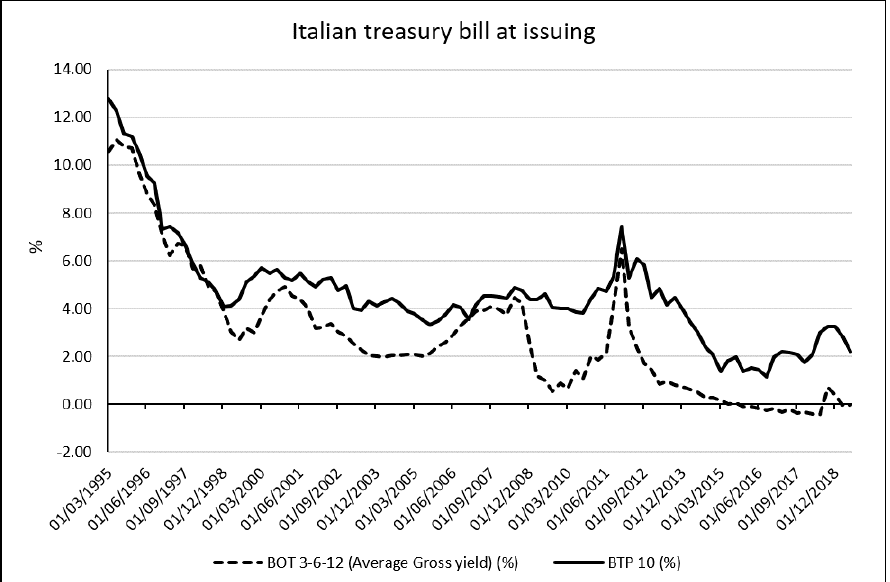
Figure 4. Italian treasury bill at issuing for the period from 1995:Q1 to 2019:Q2. (data source: Bank of Italy, 2019, ‘own elaboration’).